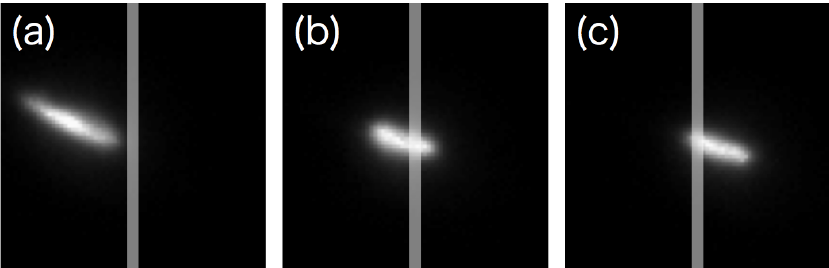
Figure 6. Fast camera images corresponding to the timings when the spectra in Figure 5 are obtained. The vertical lines indicate the virtual band-shaped field-of-view used for deriving the solid line in Figure